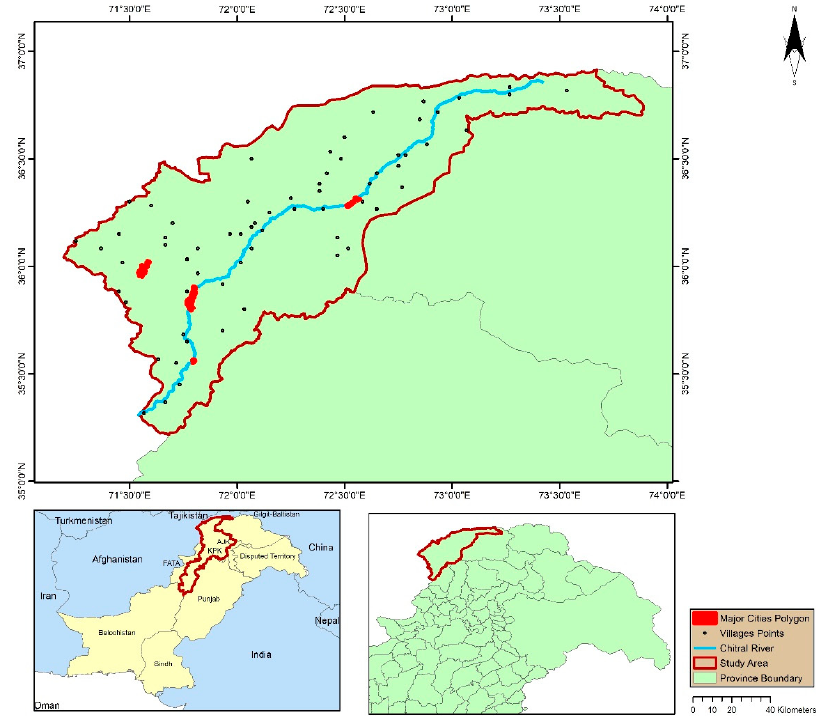
Figure 1. Map of Chitral district.